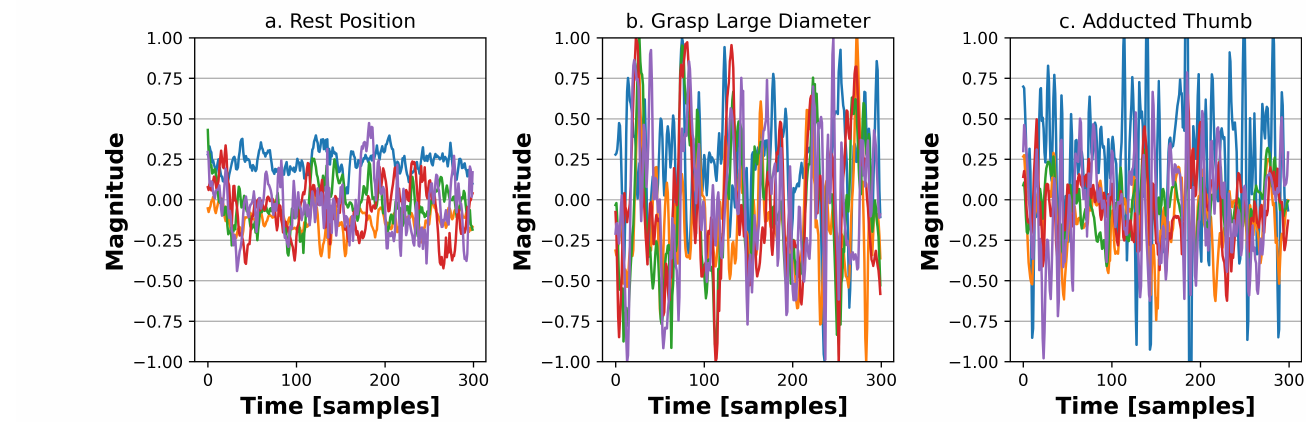
Figure 2. Examples of sEMG signals from [7] corresponding to different gesture classes.